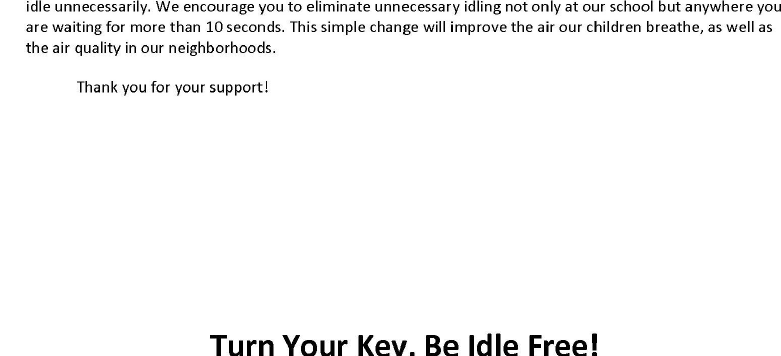
Figure A10. Idle-free schools letter to delivery truck drivers.